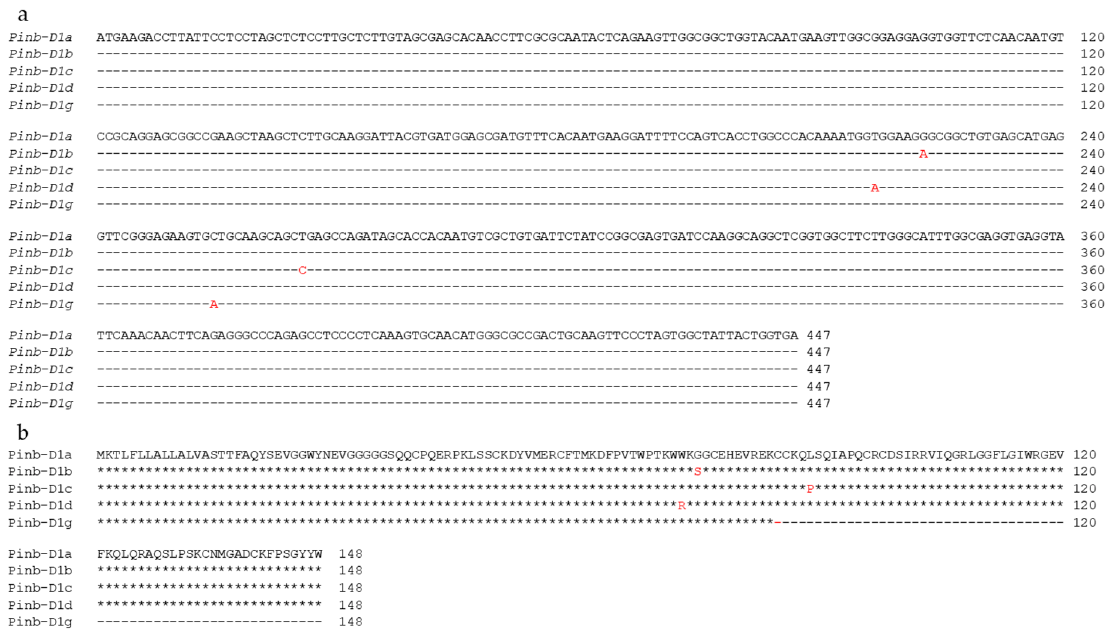
Figure 1. ( a ) Alignment of the nucleotide and ( b ) amino acid sequences of Pinb alleles detected in the tested cultivars.